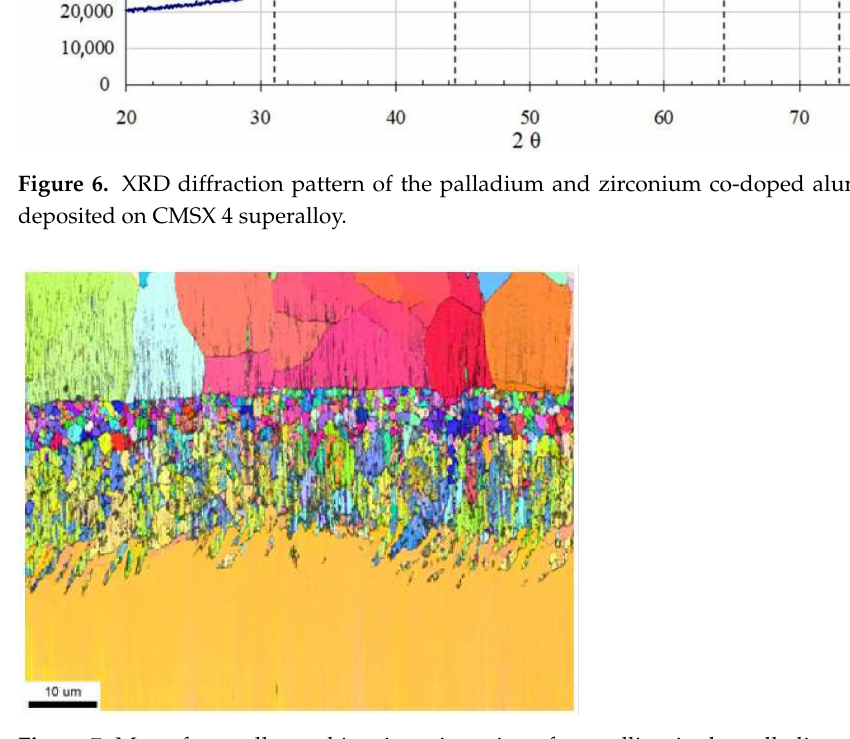
Figure 7. Map of crystallographic miss-orientation of crystallites in the palladium and zirconium co-doped aluminide coating.